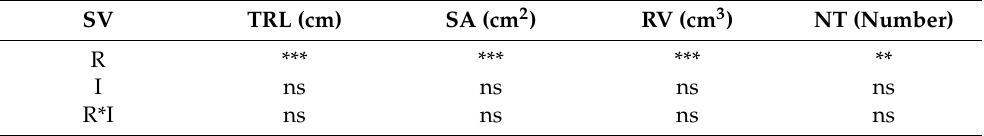
R*I SV: source of variation. The levels of significance (ns: non-significant; ** significant at 1%; *** significant at 0.1% using the F-test) are indicated. Means followed by different letters are significantly different according to Fisher’s LSD test ( p ≤ 0.01) with Bonferroni Table 3. Type III analysis of rootstocks (R), irrigation levels (I), and their interaction (R*I) on the total root length (TRL), root surface area (SA), root volume (RV), and the number of tips (NT) of five